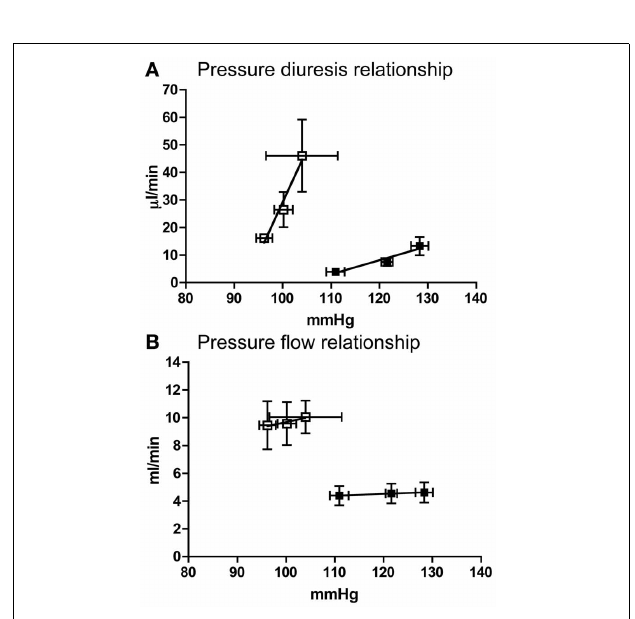
FIGURE 2 | (A) Pressure diuresis and (B) pressure flow relationship in Lewis ( n = 8; open squares) and F344 ( n = 7; black squares) rats. Data are mean ± SE . Statistical test was performed by linear regression